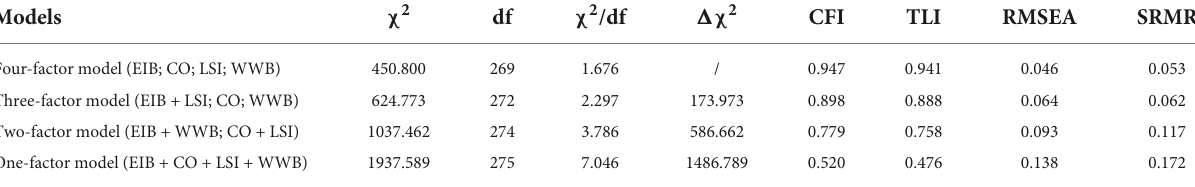
TABLE 3 Results of confirmatory factor